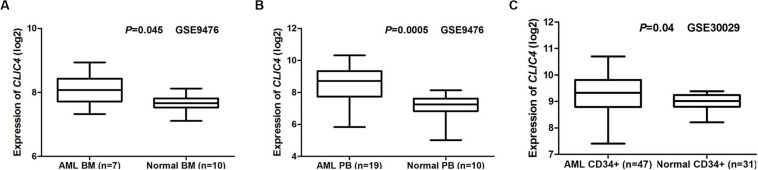
Different expressions of CLIC4. (A) AML bone marrow samples (n = 7) vs. normal bone marrow samples (n = 10). (B) AML peripheral blood samples (n = 19) vs. normal peripheral blood samples (n = 10). (C) AML CD34+ samples (n = 47) and normal CD34+ samples (n = 31). AML, acute myeloid leukemia.